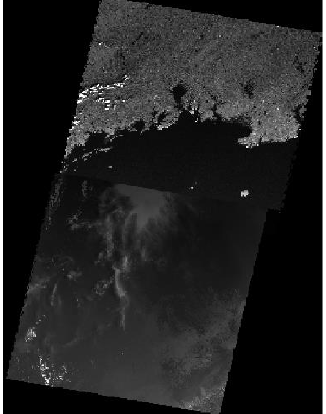
Figure.12 processed remote sensing image by the new graduation algorithm o